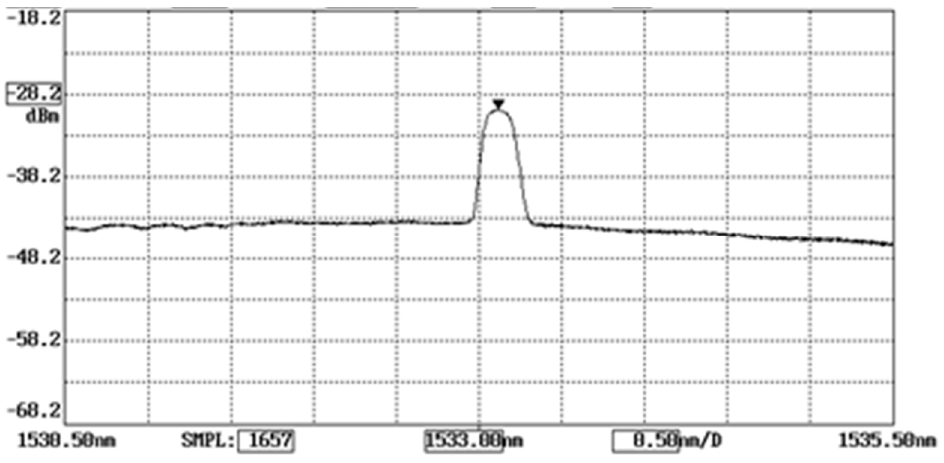
Figure 4. Wavelength of FBG sensor.